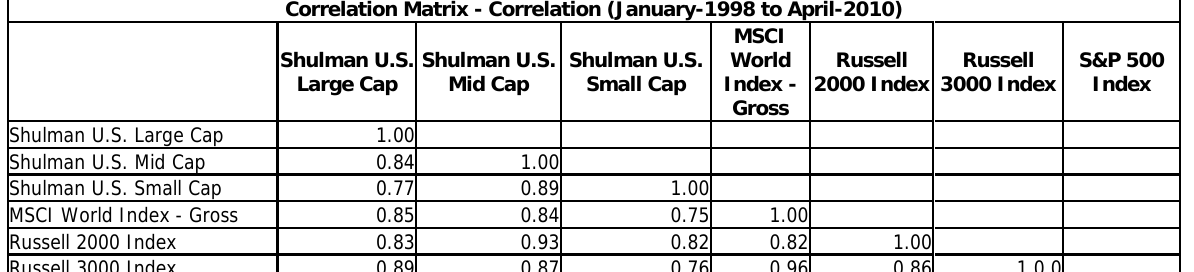
Correlation Matrix - Correlation (January-1998 to